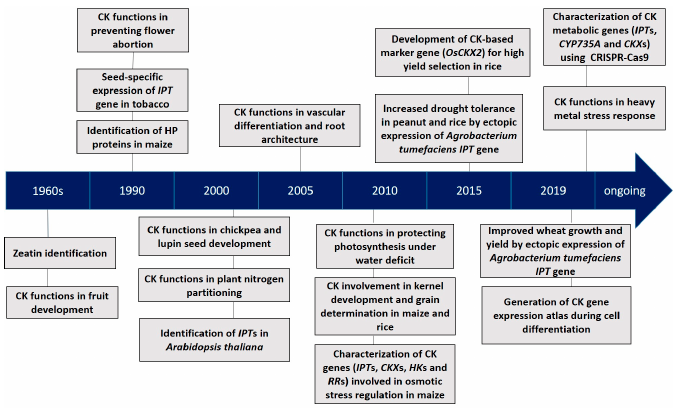
Figure1. Atimelineofkeyprogressesincytokinin(CK)research[23–45]. HP:Histidinephosphotransfer; Figure 1. A timeline of key progresses in cytokinin (CK) research [23–45] . HP: Histidine phosphotransfer; IPT: isopentenyl transferase. IPT: isopentenyl